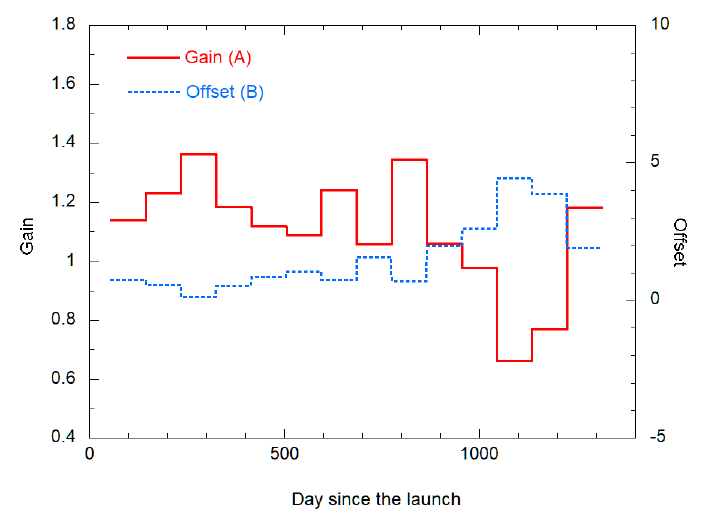
Figure 19. Gain and offset for recalibrating the ground testing-based radiance ( R 1 ) for CALET/CIRC as a function of the day since the launch ( D ).